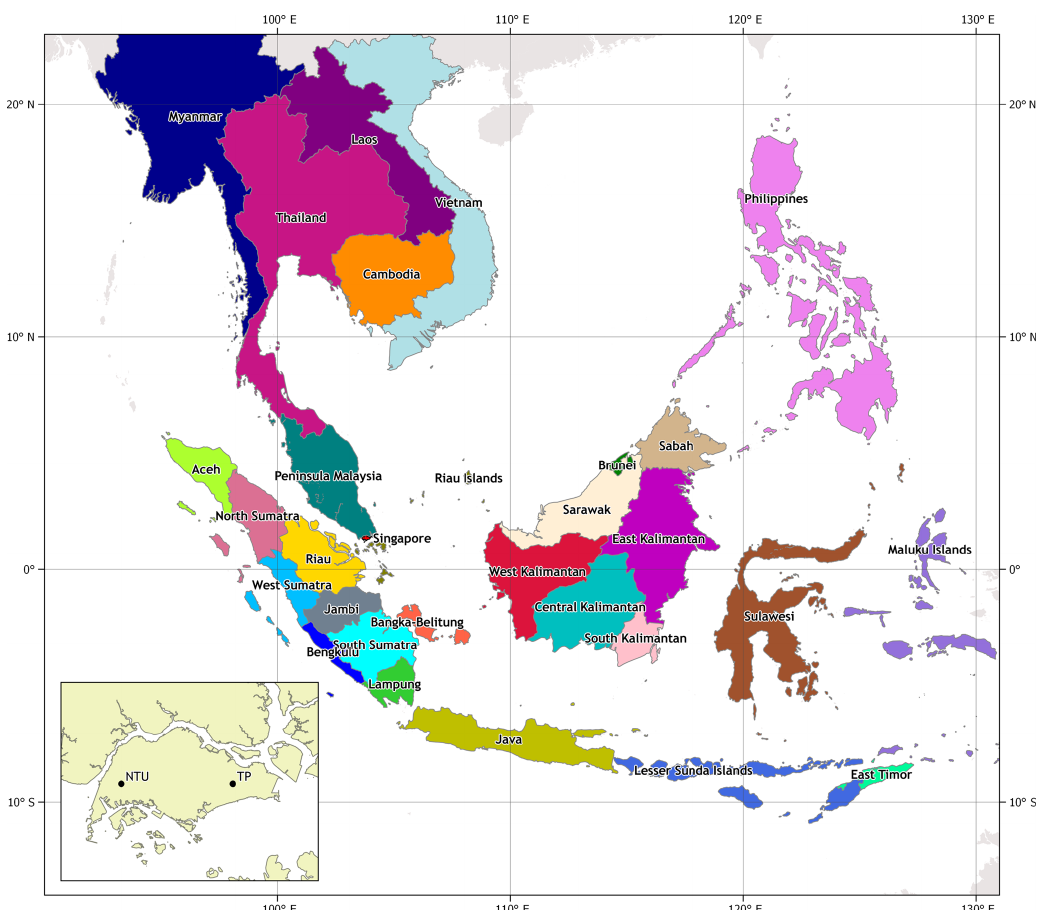
Figure 1. Locations and colour codes used for each of the 29 biomass burning source region within the domain from 10 ◦ S to 0 ◦ N and from 90 to 130 ◦ E considered in this study. Singapore is located south of Peninsular Malaysia and east of Riau. The insert in the bottom left-hand corner shows the relative location of the two monitoring stations in Singapore.